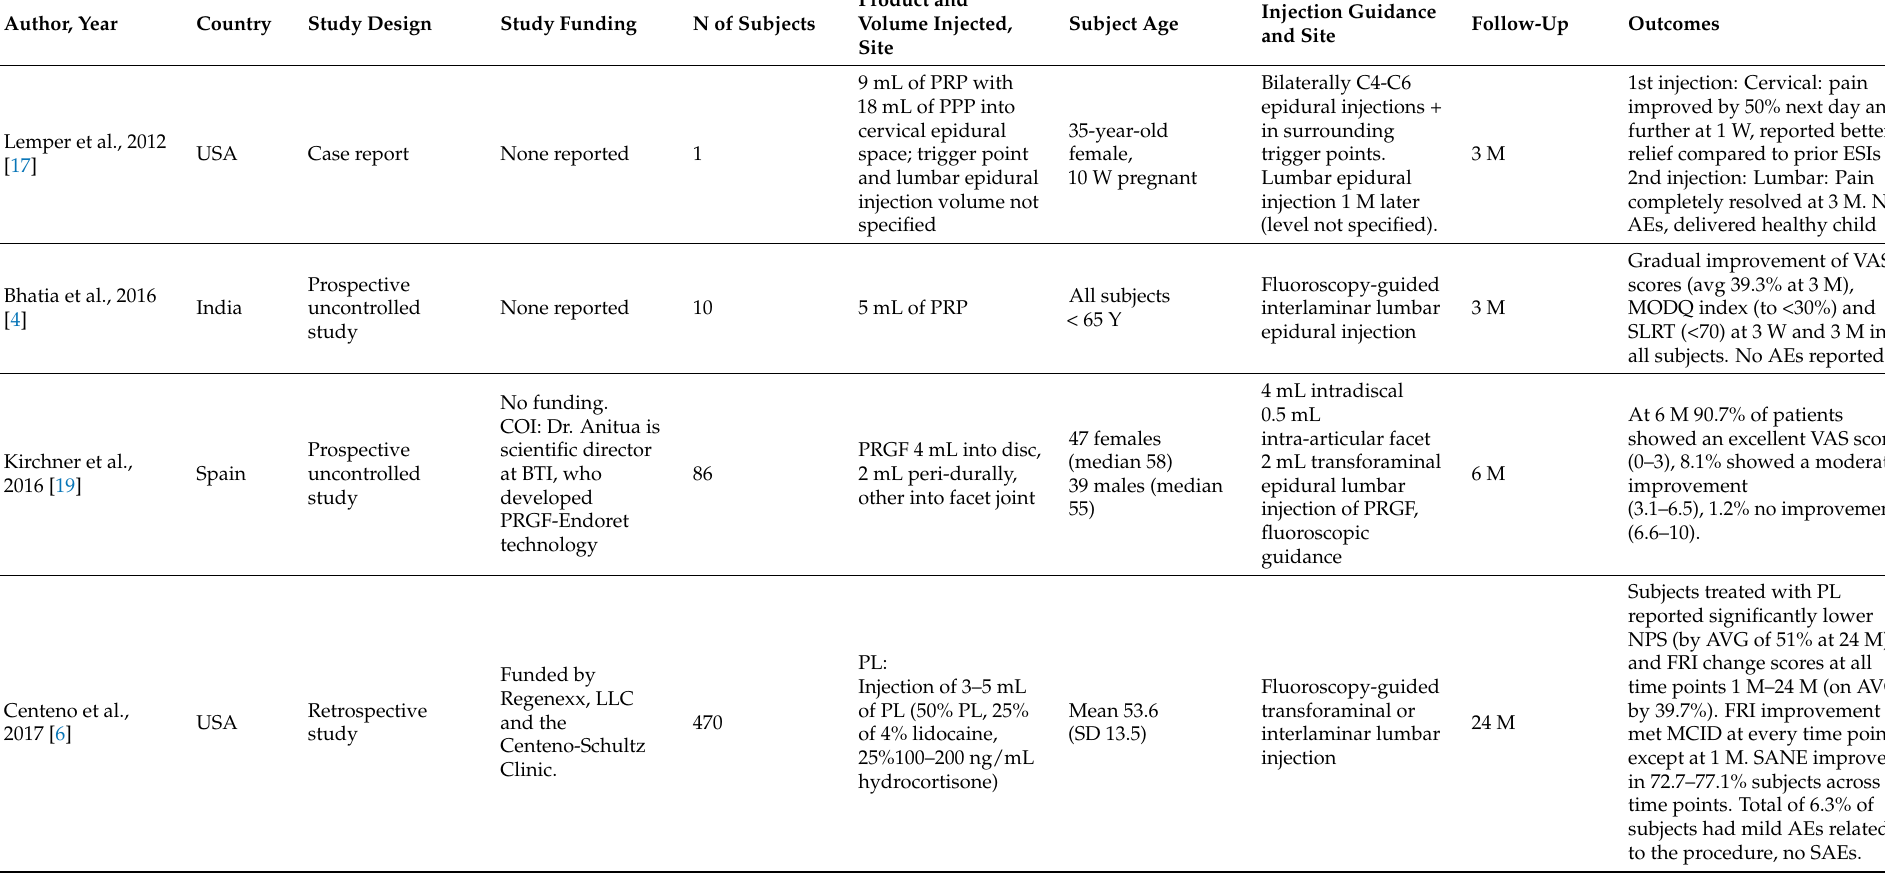
Table 1. Summary of findings of the included